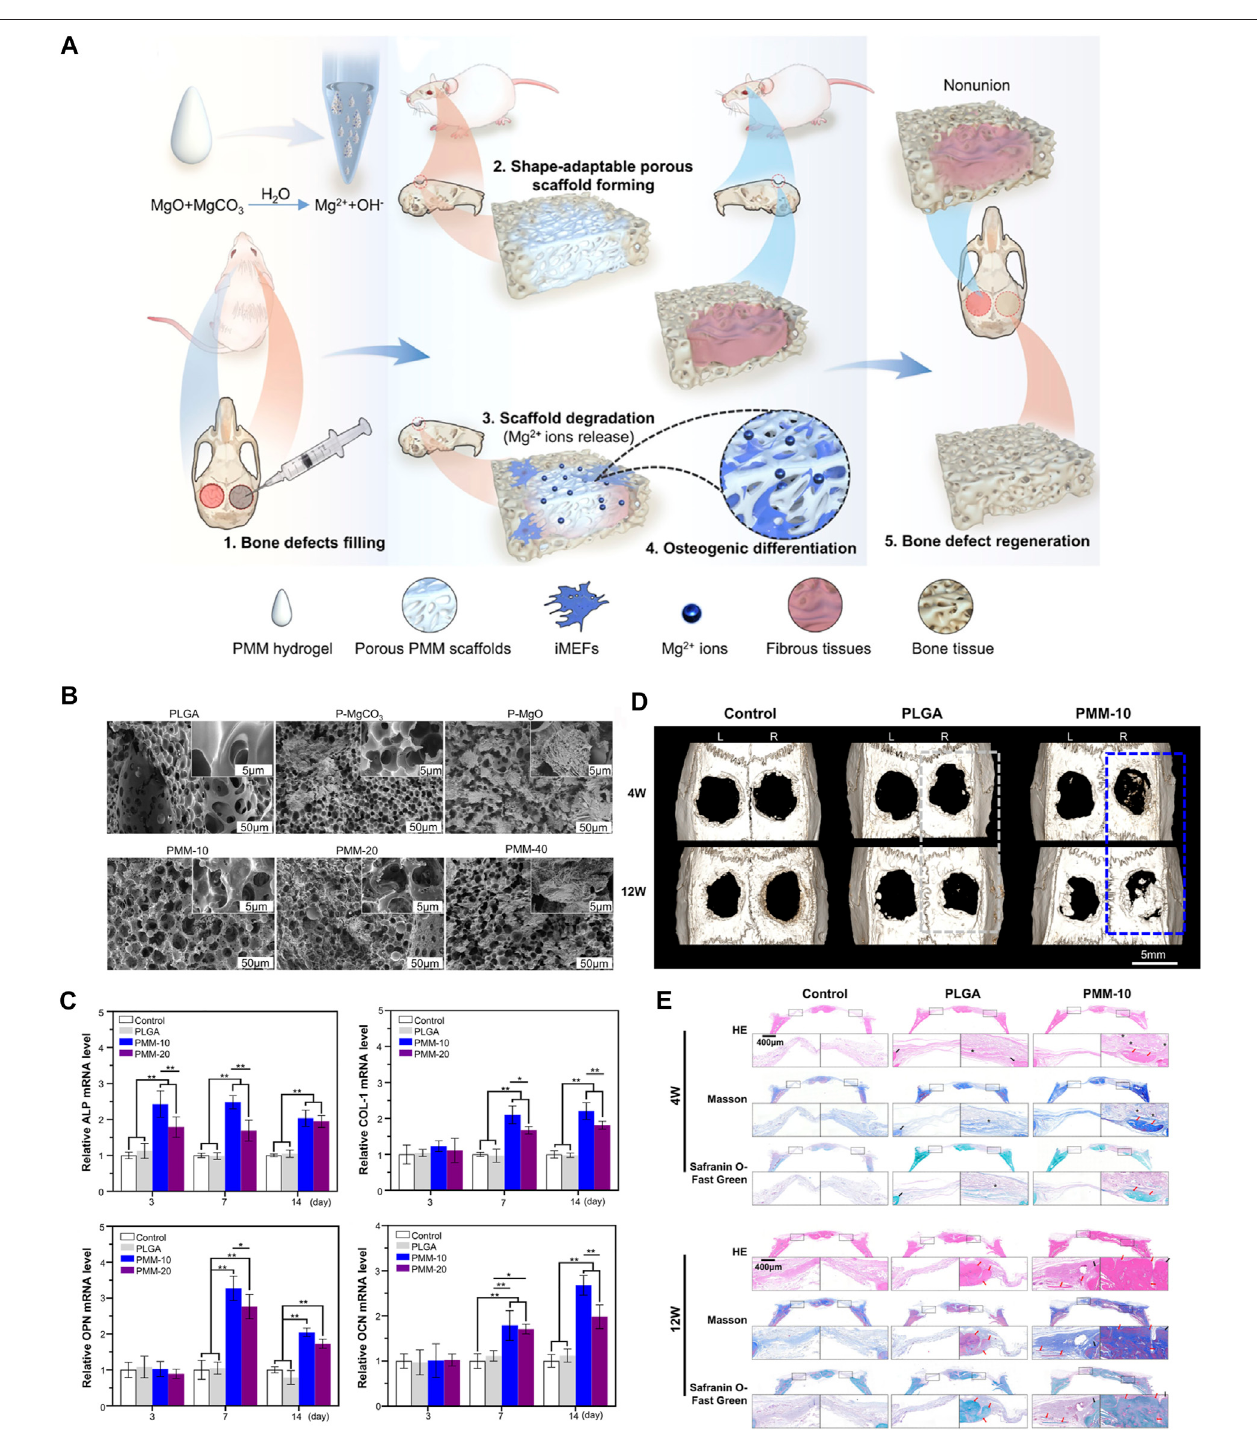
FIGURE 3 | Schematic diagram of MgO/MgCO3@PLGA(PMM) hydrogel promoting bone defect repair. (A) Schematic diagram of the mechanism of injectable PMM hydrogel promoting bone defect regeneration. (B) SEM images of PLGA and PM scaffolds loaded with MgO/MgCO particles with different weight ratios. (C) The relative expression levels of marker genes related to osteogenic differentiation were analyzed. (D) Reconstructed 3D micro-CT images of rat crania with the treated defectslabeledwithrectangularbox(gray:PLGA,blue:PMM). (E) HistologicalevaluationofbonedefectregenerationusingH&E,Masson ’ strichrome,andSafranin O-Fast Green staining (*represents residual materials showing the blank area; red arrows indicate new bone, and black arrows indicate host bone) (Zhou et al., 2021). Copyright 2021, American Chemical Society.